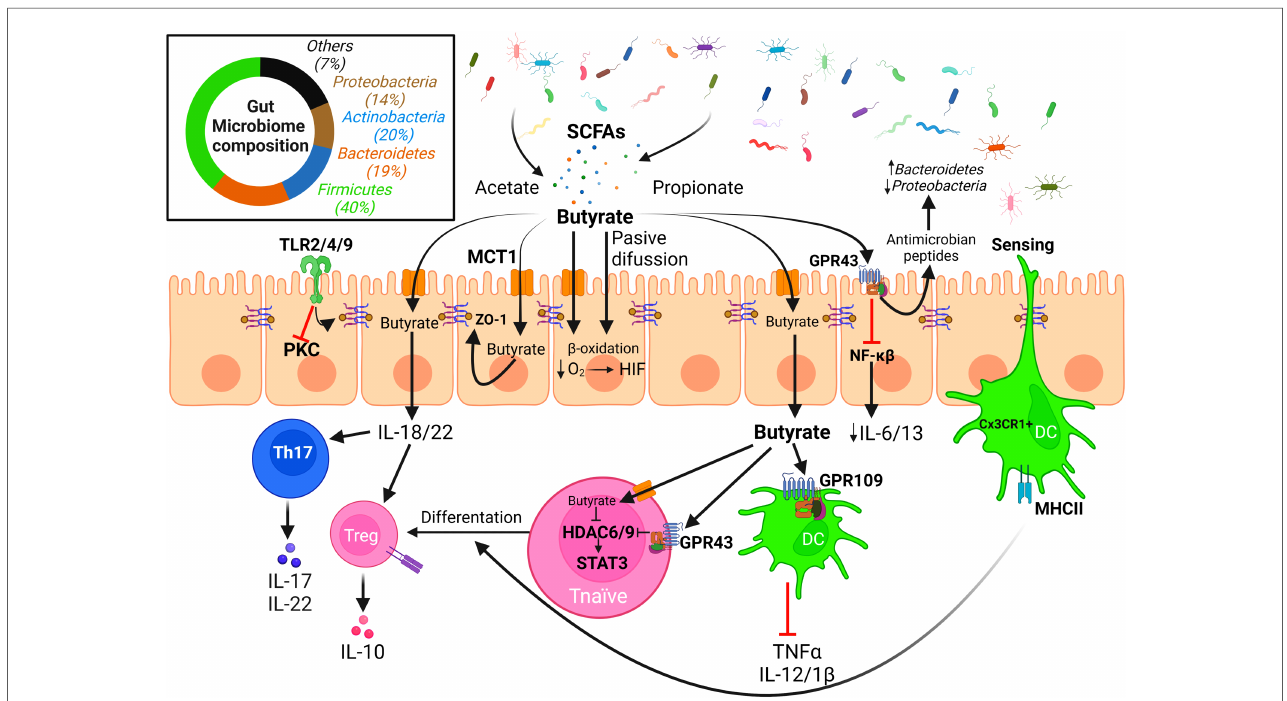
FIGURE 3 Effect of microbiota derived SCFAs on the integrity of the intestinal epithelial barrier. The intestinal microbiota is mainly composed of bacteria from the phyla Firmicutes/Bacillota, Actinobacteria , Bacteroidetes , and Proteobacteria/Pseudomonadota among other minor phyla. Diet fi ber fermentation by gut microbiota generates SCFAs that may enter the epithelial cells either through passive diffusion or via monocarboxylate transporters, or well interact with GPCRs (e.g., GPR43) present in the apical membrane. Butyrate is the main fuel and carbon source for colonocytes, but it can be exported through the basolateral membranes and interact with immune cells altering T cells differentiation and cytokine release patterns, promoting the integrity of the epithelial barrier. Biological effects of butyrate are mainly related to its activity as inhibitor of HDACs, effect that is enhanced via interaction with GPR43 that induces a down-regulation of HDAC expression (Created with